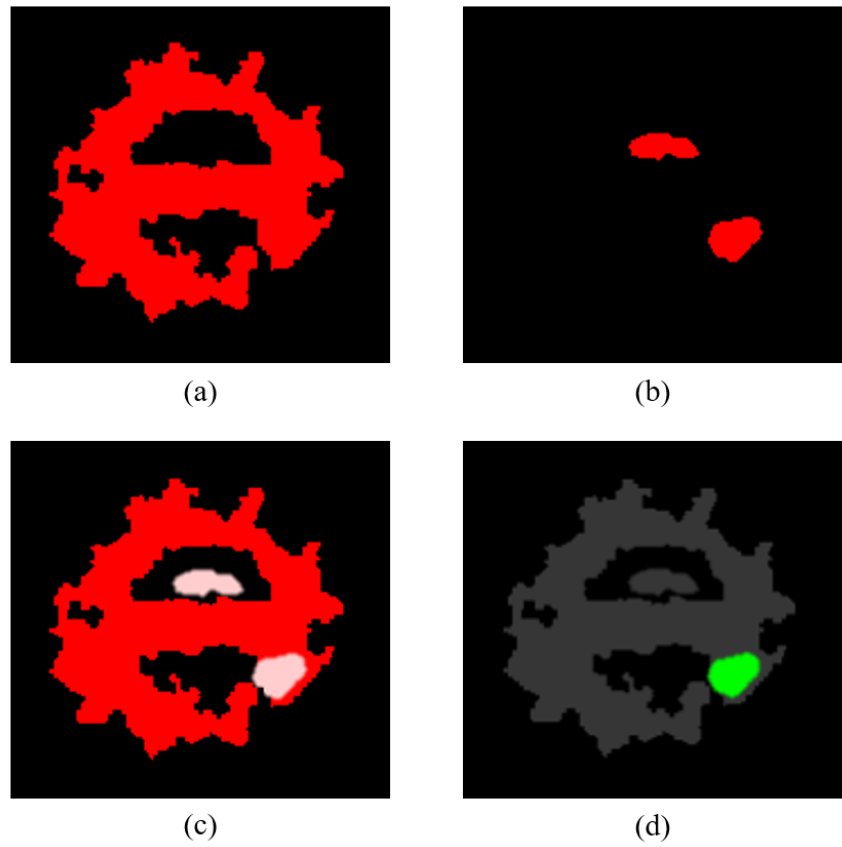
Figure 9. Example of fusion processing of binary forms of RGB and depth images to determine locations of rocks: ( a ) binary image of hopper, ( b ) binary image of rocks, ( c ) superimposed binary image of hopper and rocks, and ( d ) detected rocks (highlighted in green).